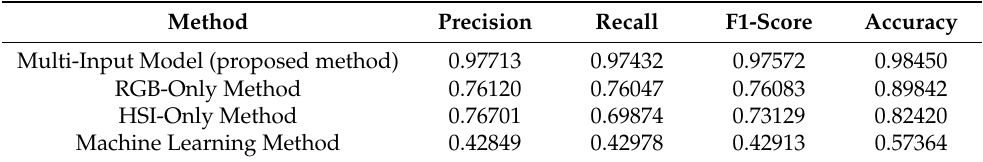
Table 6. Comparison of the different methods using different modalities and feature sets for banana class